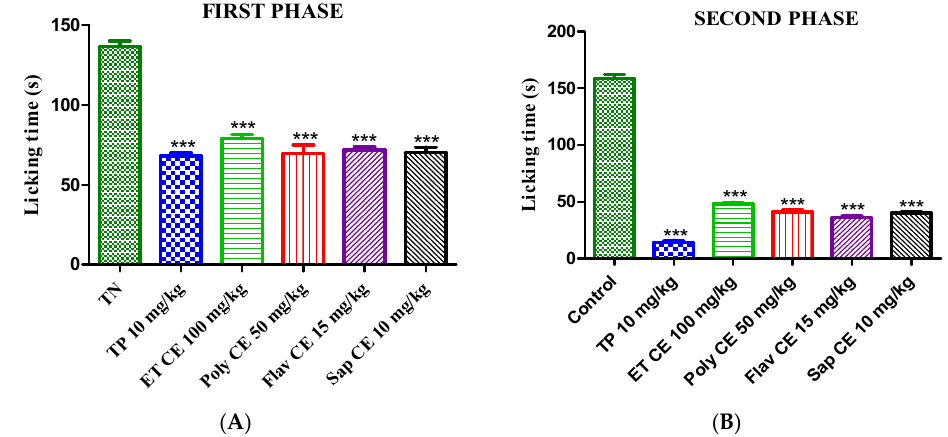
Figure 5. The antinociceptive activity of the C. europaea extracts on formalin-induced pain in mice during the first ( A ) and second ( B ) phases. Values are expressed as mean ± SEM. Results are statistically different from the negative control ***: p < 0.001.